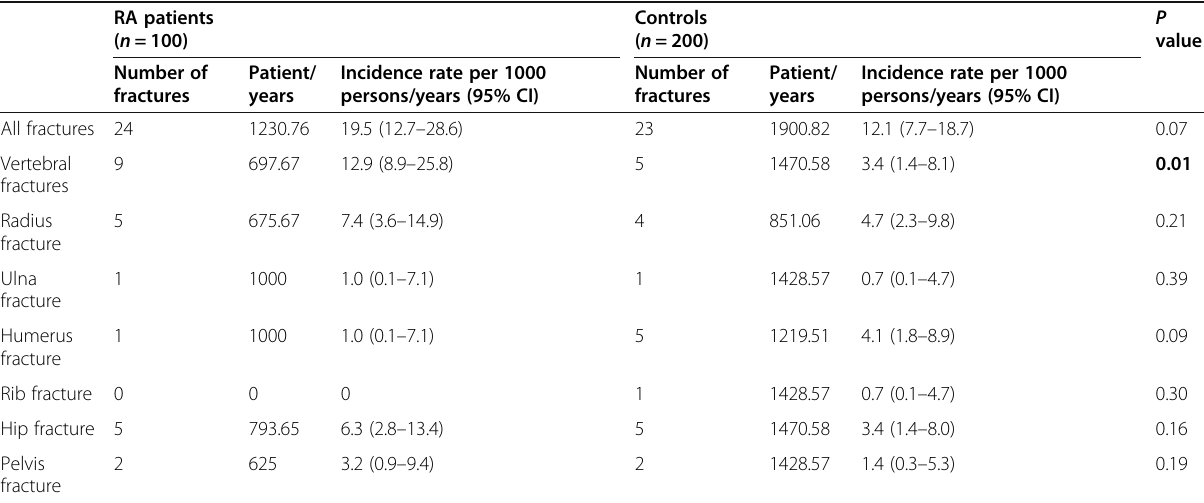
Table 2 Incidence rates of distinct types of fractures RA patients ( n =